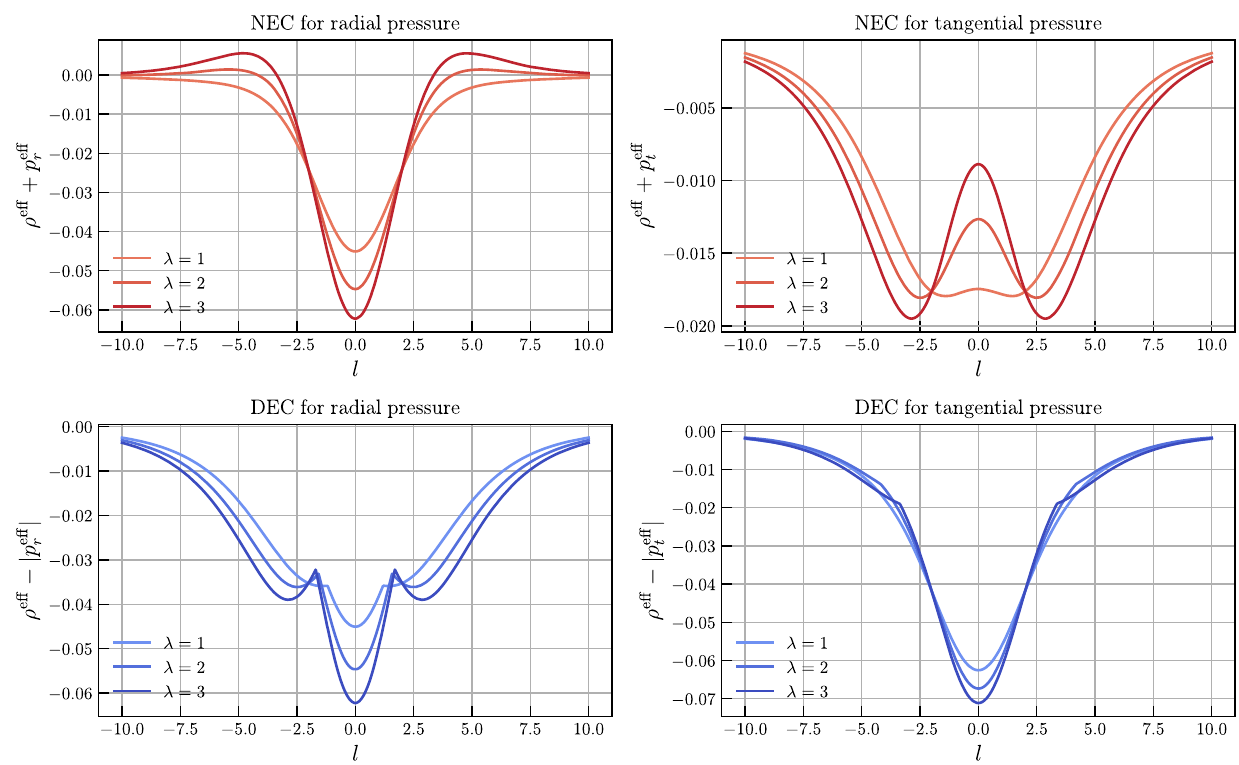
Fig. 2 Null, Dominant and Strong energy conditions for GEB wormhole in the Hu–Sawicki gravity conjucture. To plot the results, we have considered that wormhole throat is equal to b 0 = 5, and also cosmological constant was set to unity. Furthermore, m = 2 and α = 0 . 5, β = 0 . 1, R c = n =